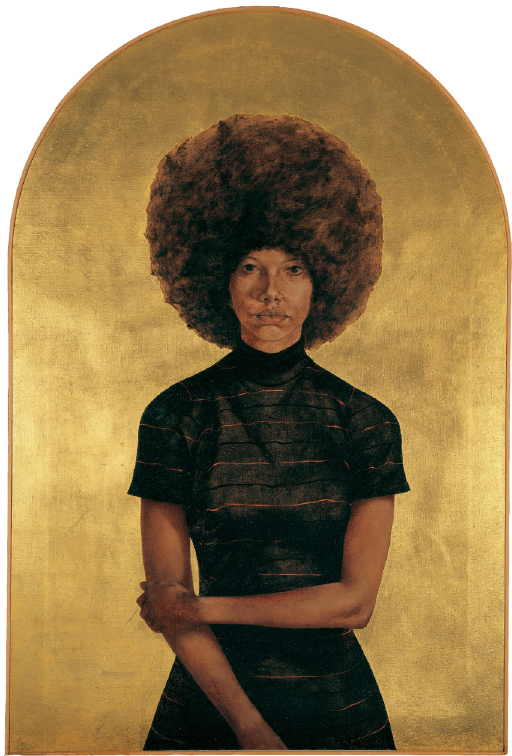
Figure 12. Hendricks, Barkley L. Lawdy Mama (1969). oil and gold leaf on canvas 53 3/4 x 36 1/4 inches ©Estate of Barkley L. Hendricks. Courtesy of Jack Shainman Gallery, New